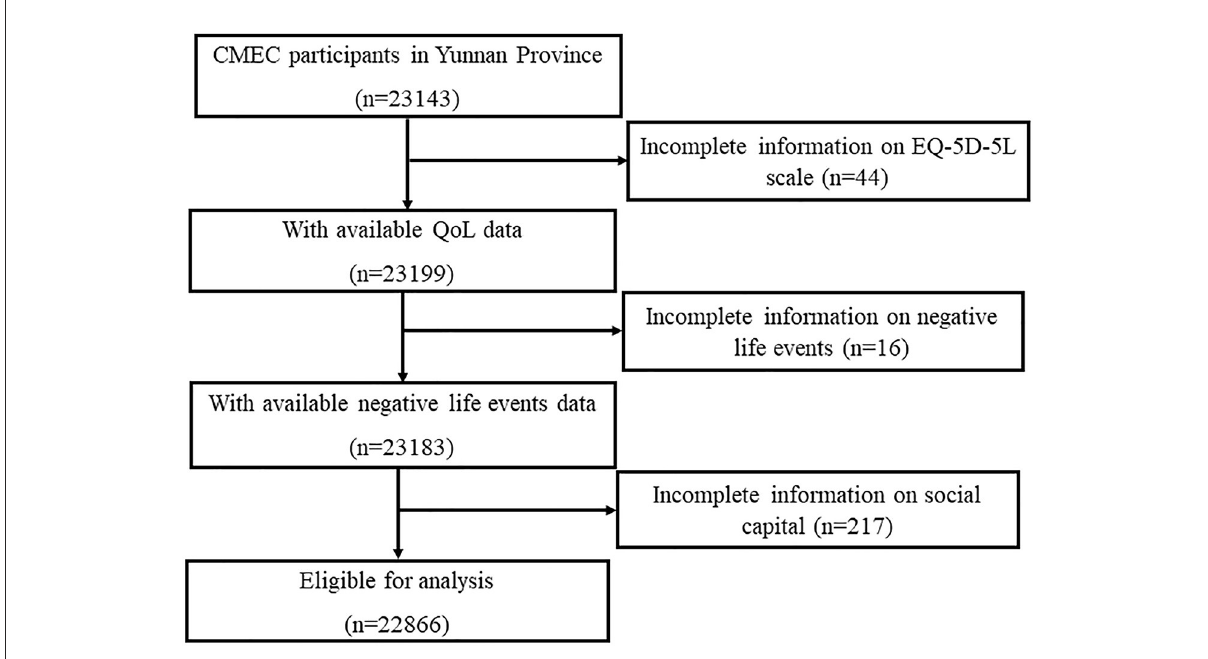
FIGURE1 Flow diagram of selection of